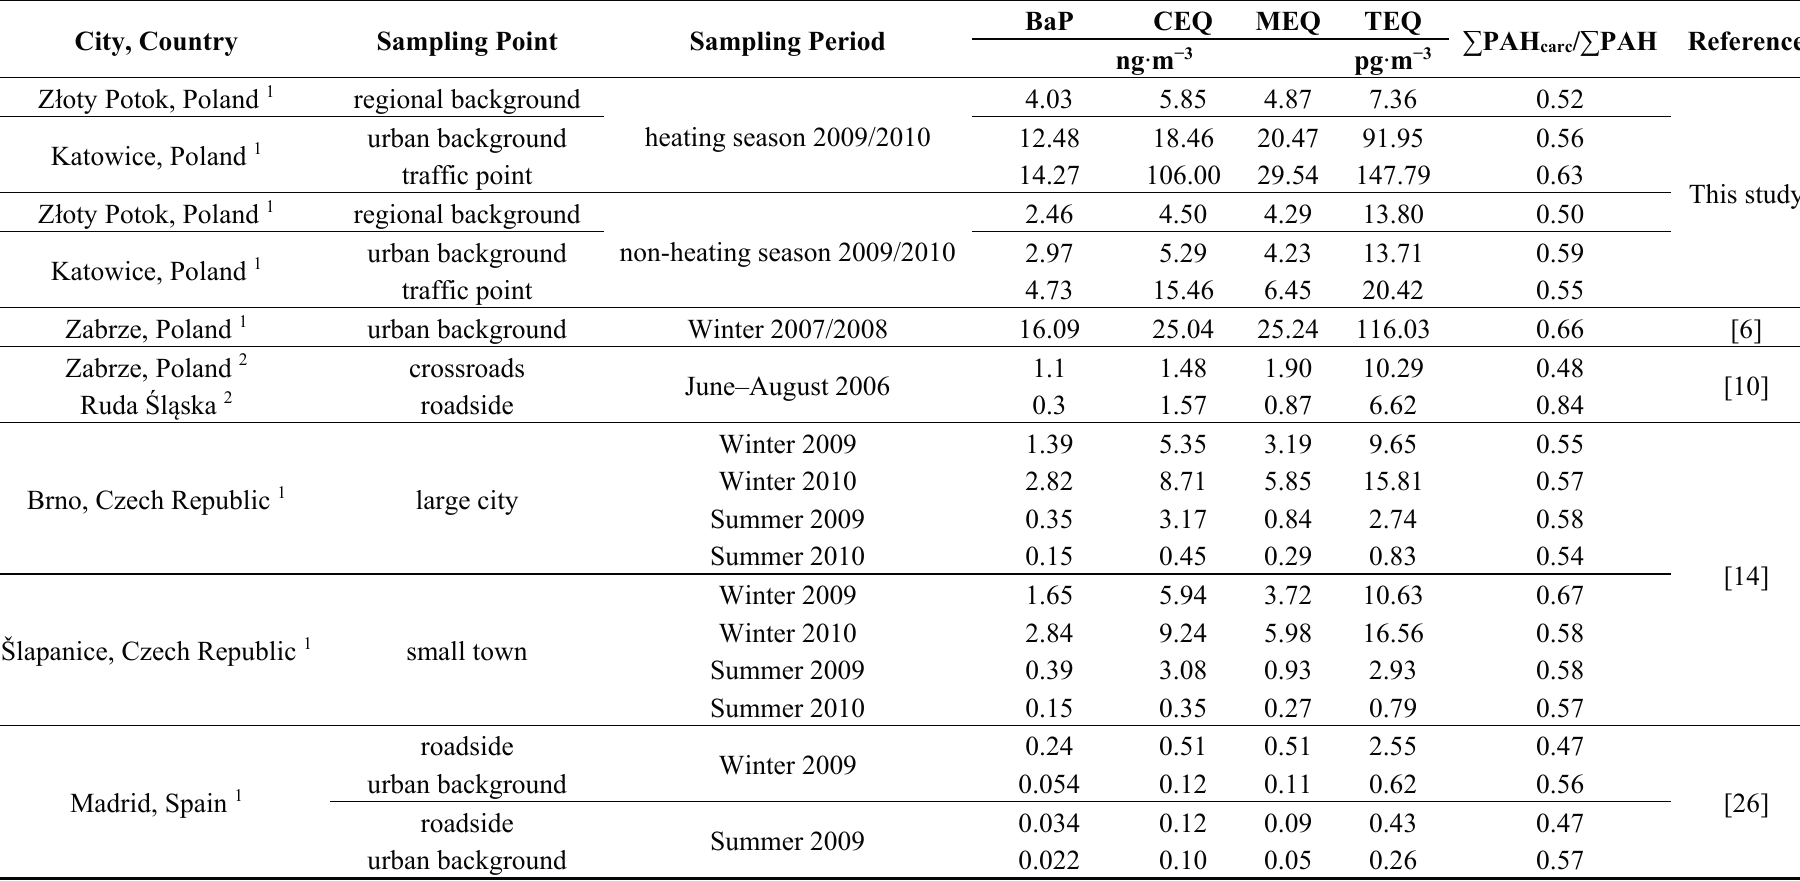
/ ∑ PAH for PM-bound PAHs in various world carc